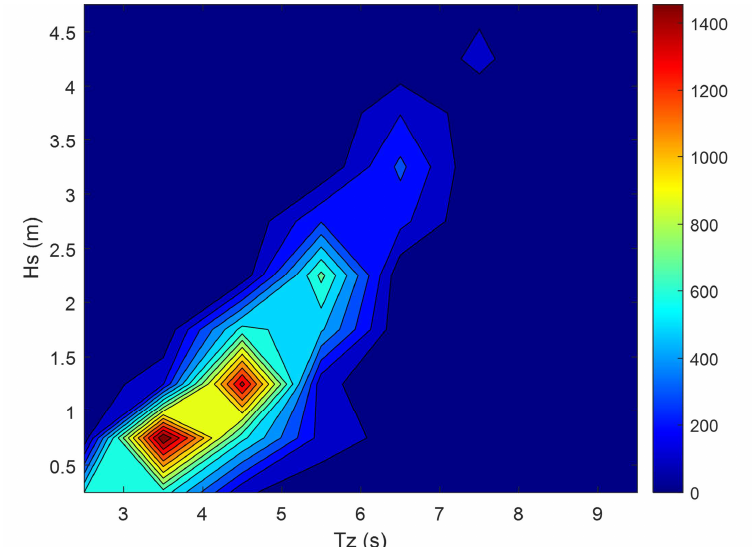
Figure A2. Hours of occurrence of each wave state of DK 2 [14].